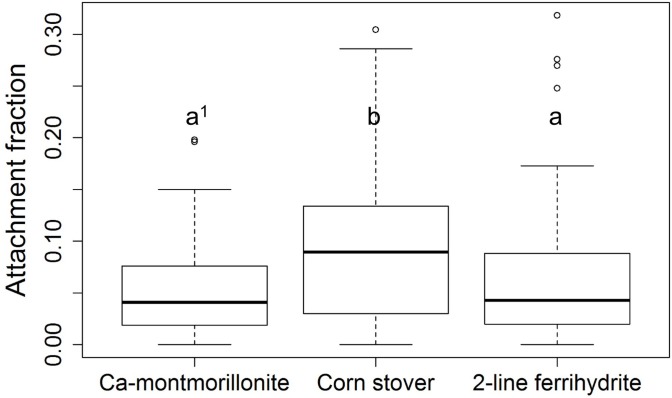
Boxplot2 of attachment fractions for each particulate type.1. Values with the same letter are not different at α = 0.05, as determined by a Wilcoxon test. 2. Each plot shows five numerical values: the smallest observation (Q1 = Q2-1.5(Q4-Q1), the low end of the whisker), 25% quartile (Q2, low boundary of box), median (Q3, the band near the middle of box), 75% quartile (Q4, high boundary of box), and largest observation (Q5 = Q4+1.5(Q4-Q1), the high end of the whisker). Outliers, which are out of the range [Q1, Q5], are indicated by open circles.